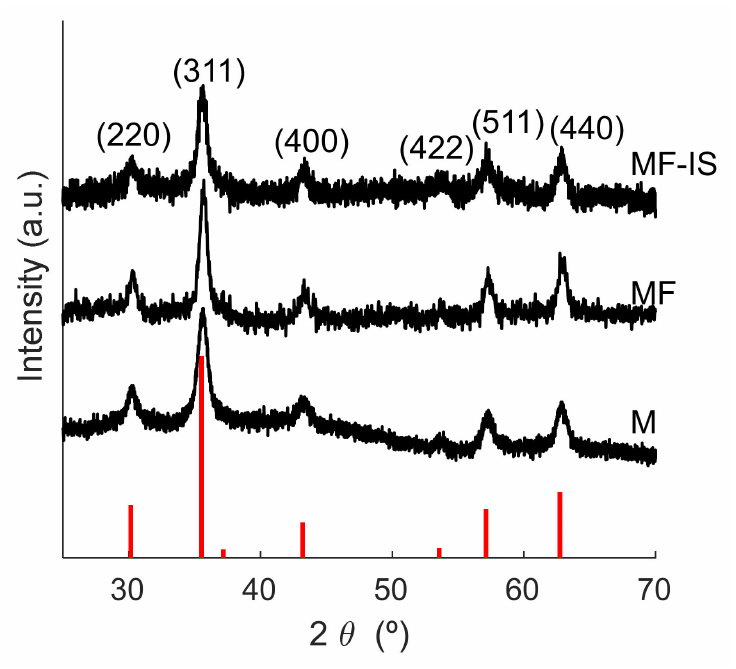
Figure 2. Normalized XRD diffractograms of magnetite (M), post-synthesis fucoidan-coated mag- netite (MF), and in situ fucoidan-coated magnetite (MF − IS) samples. The red lines represent the peaks of the Fe 3 O 4